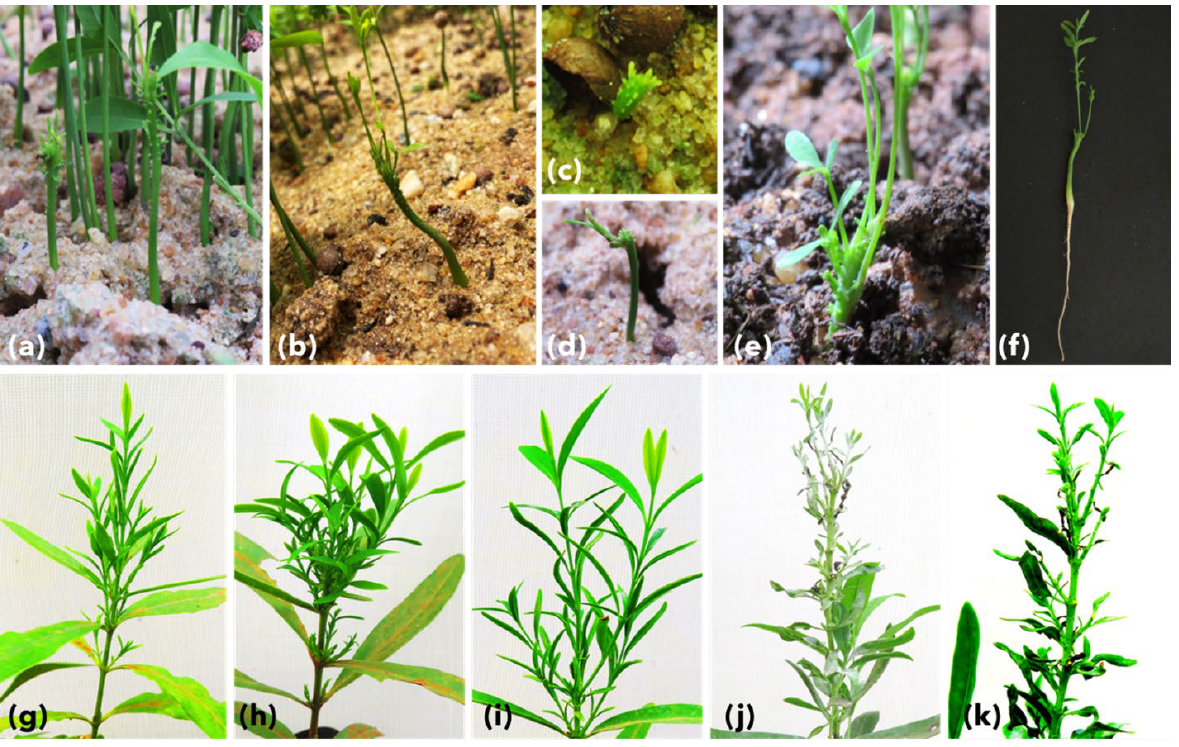
Figure 2. Sandalwood seedlings at 35–40 DAS showing SDD symptoms such as a little leaf, malformation of leaves and leaf laminae, stunted and abnormal growth, puckering of leaves, shortened internodes ( a – f ) and 100–120 DAS with SSD symptoms show symptoms of a little leaf, stunted growth, multiple abnormal shoots, shortened internodes, curling, mottling, and puckering of leaves leading to drying and abscission of leaves ( g – k ).